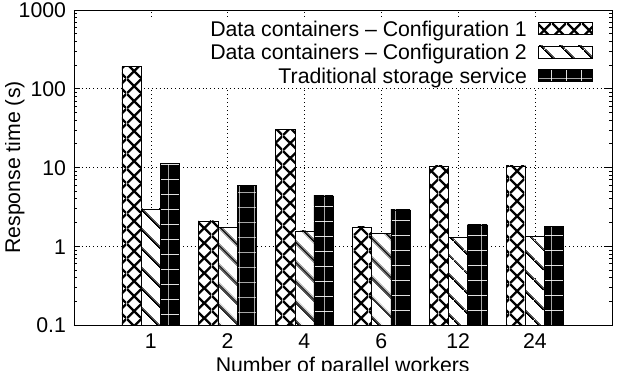
Figure 9. Response time when managing ECG data through a structure considering three stages: ECG sensor simulator, QRS-complex detection, and data